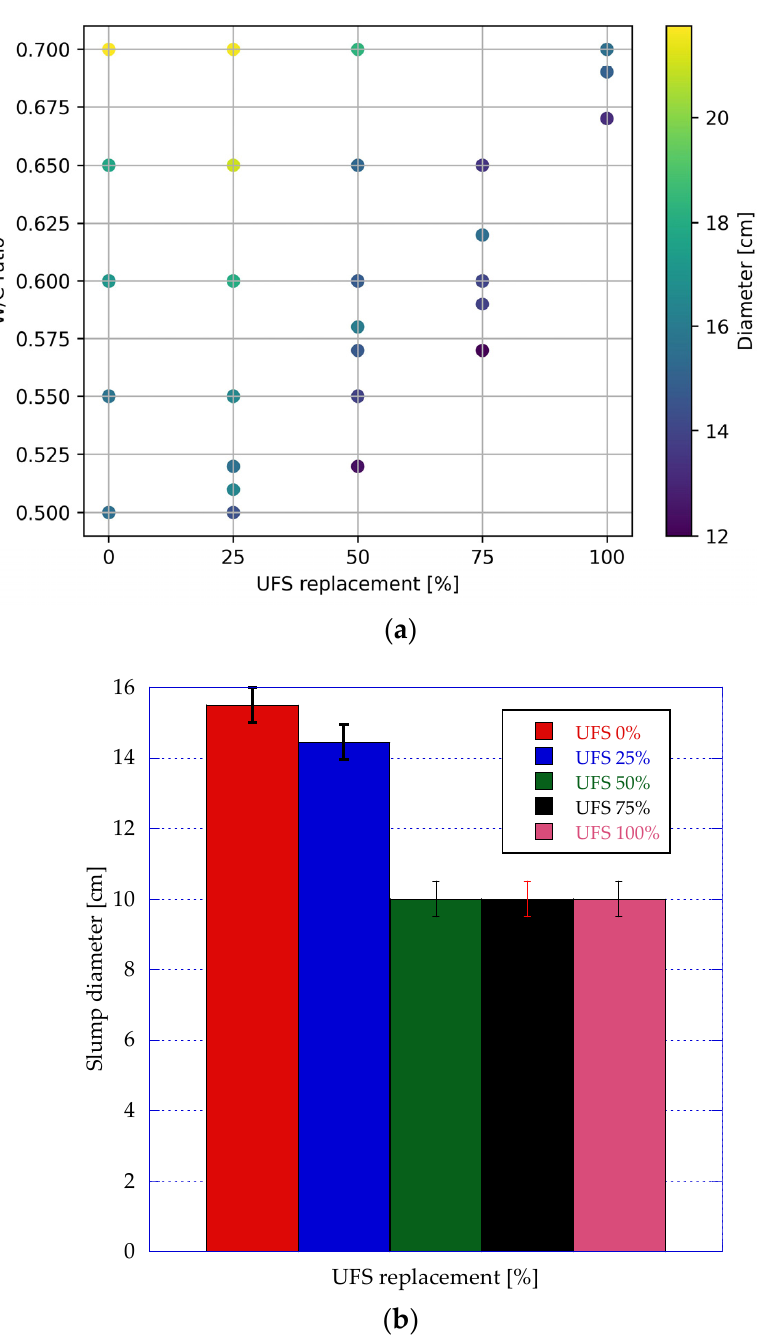
Figure 7. Mortar workability: slump table test results in cm ( a ); effect of UFS in mortar workability with W/C = 0.5 ( b ).